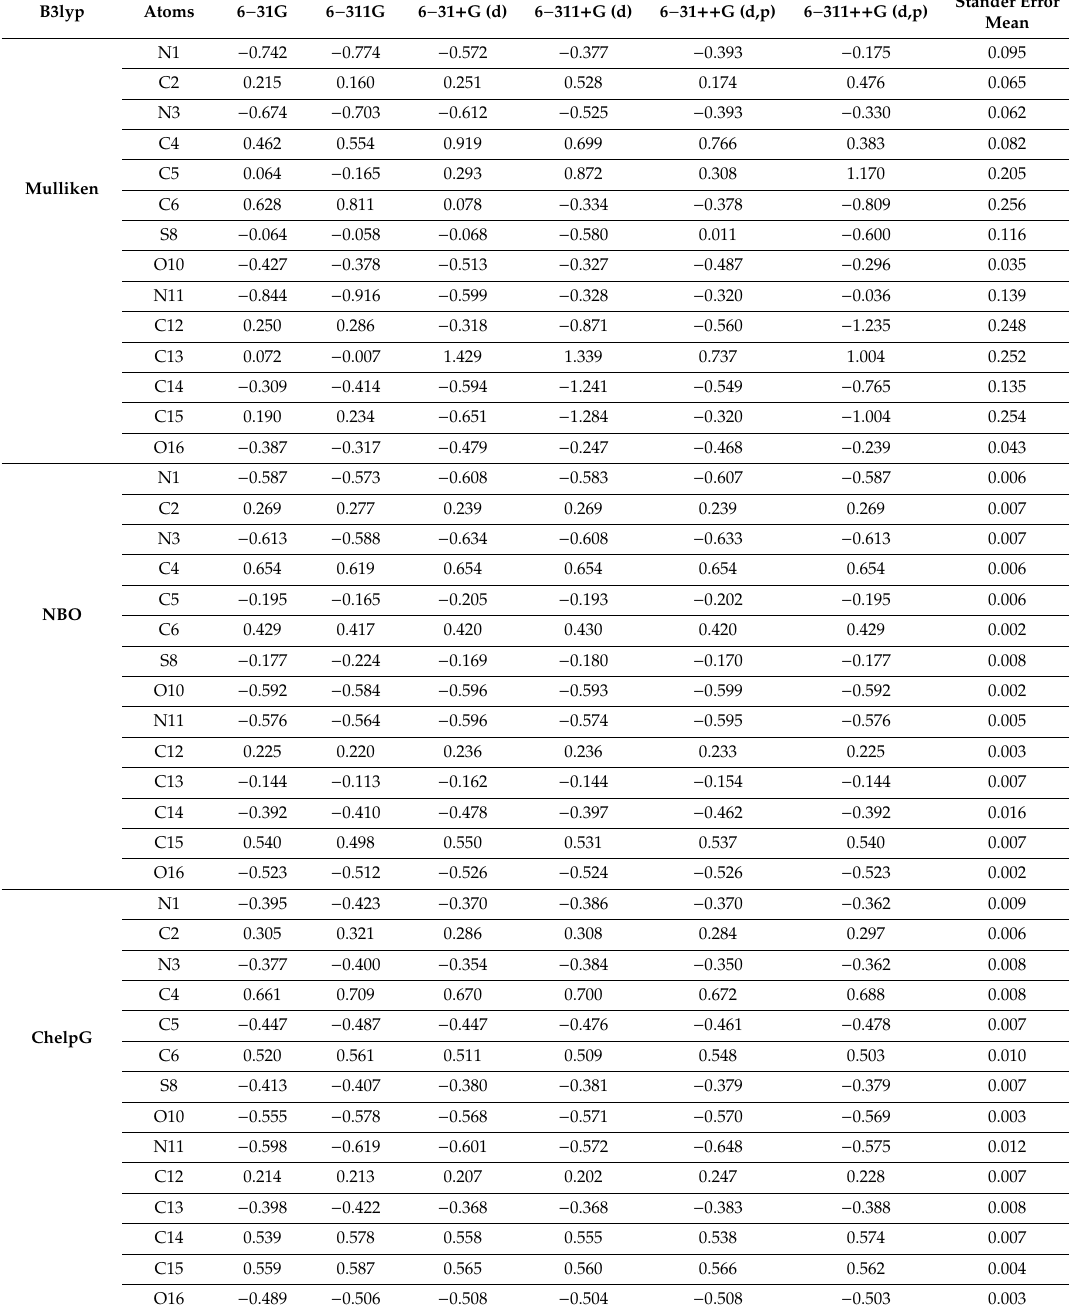
Table 2. Selected calculated partial charges of compound 1H using DFT (B3LYP functional) at di ff erent basis